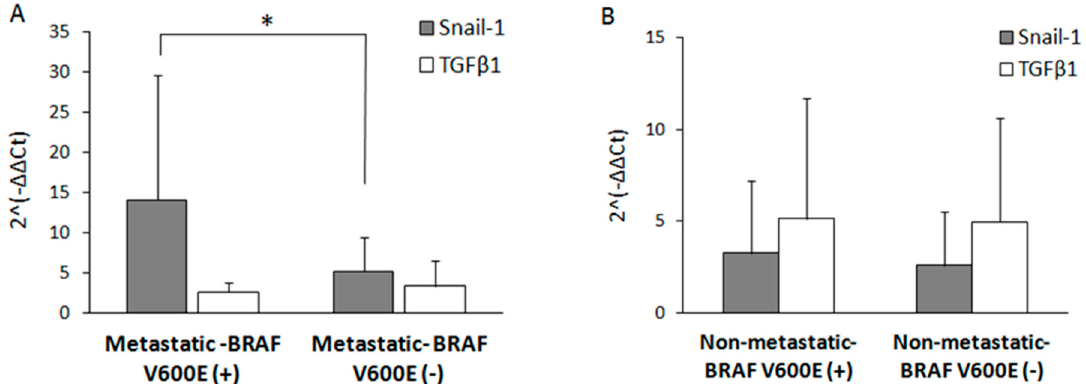
Figure 4. The upregulation of Snail-1 in metastatic PTC samples is dependent on BRAF V600E mutation status. The gene expression was evaluated by quantitative RT-qPCR in both BRAF V600E ( + ) ( n = 10) and BRAF V600E ( − ) metastatic ( n = 8) ( A ) and non-metastatic BRAF V600E ( + ) ( n = 20) and BRAF V600E ( − ) ( n = 23) PTC groups ( B ). The relative mRNA level was normalized to GAPDH. The results are presented as the mean of three independent experiments ± SD. * p < 0.05.